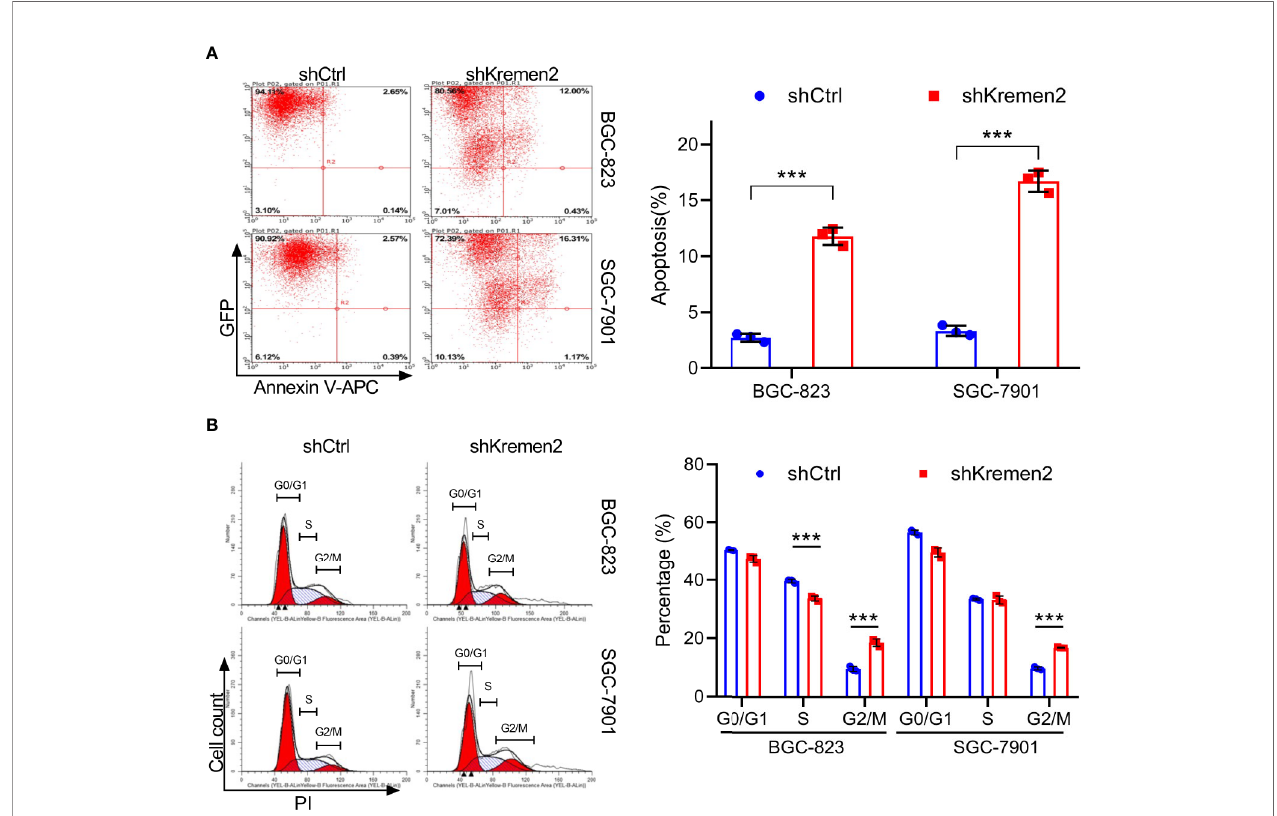
FIGURE 3 | Kremen2 knockdown induced apoptosis and cell cycle arrest at G2/M phase in GC cells. GC cells transfected with Lenti-shKremen2 or Lenti-shCtrl. (A) Kremen2 knockdown triggered apoptosis of GC cells. Transfected GC cells were stained with Annexin V-APC to detect by fl ow cytometry. (B) Kremen2 knockdown induced cell arrest of GC cells at G2/M phase. Transfected GC cells were fi xed and stained with PI to analyze DNA content by fl ow cytometry. *** P <